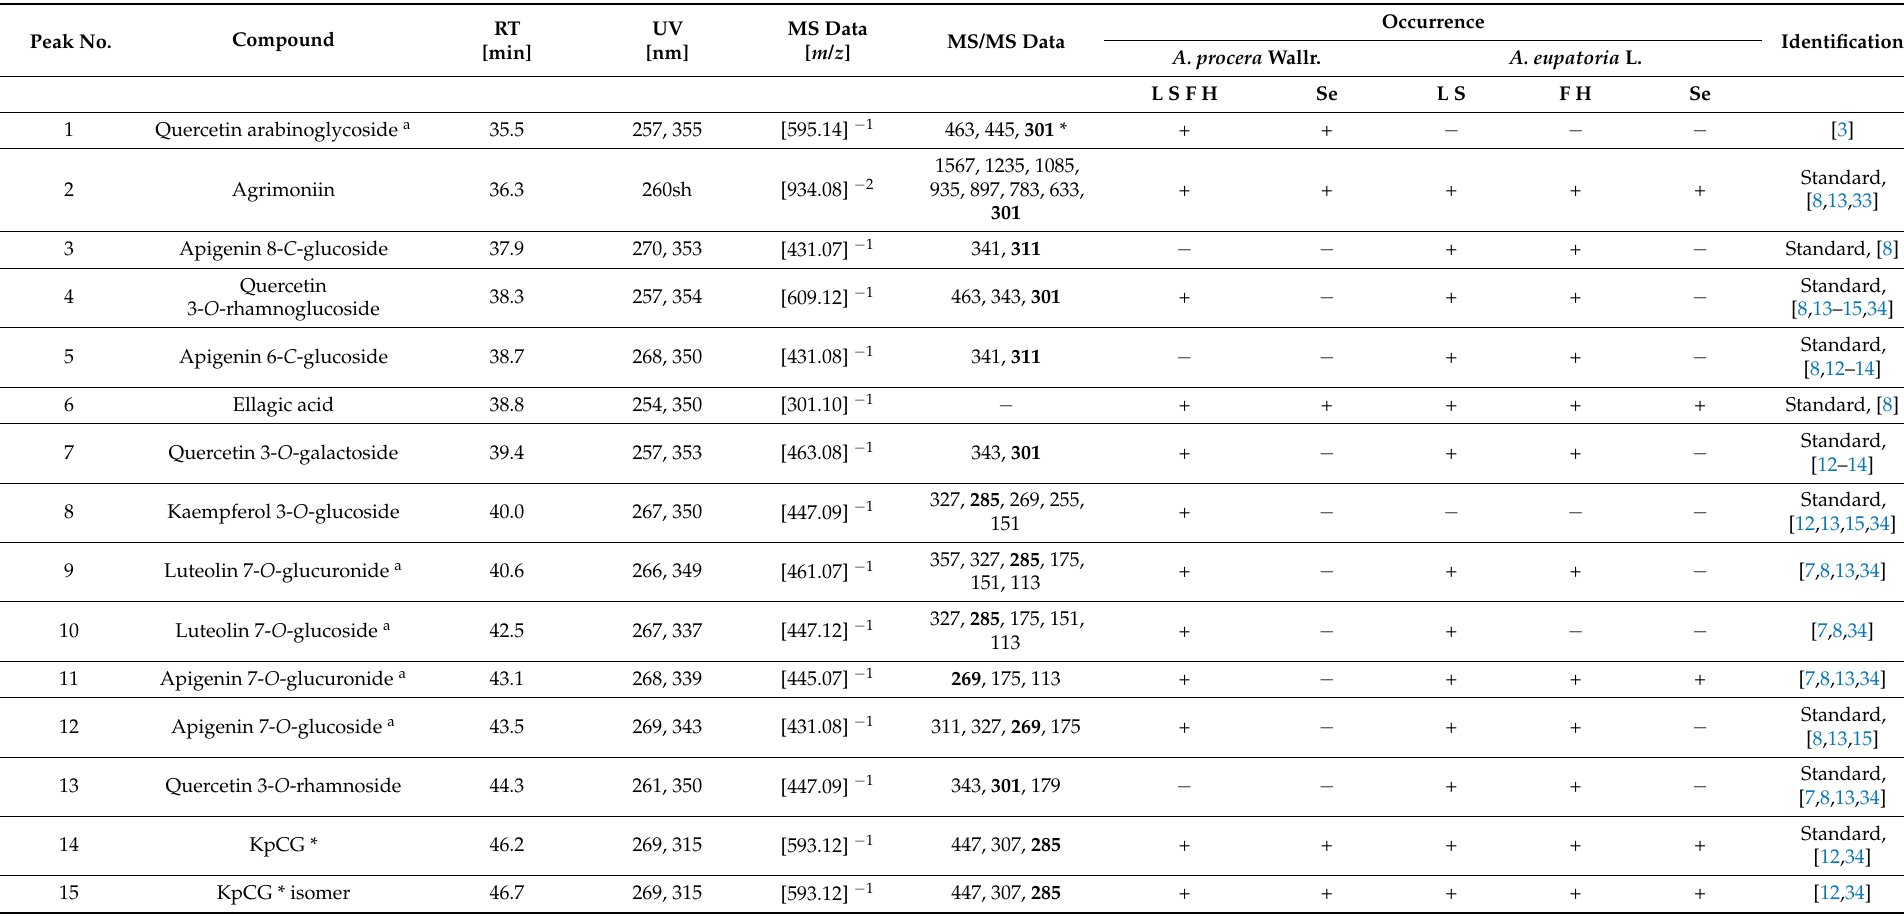
Table 1. LC-MS identification of agrimoniin and flavonoids in the leaves, stems, fruits, seeds, and hypanthia of A. procera and A. eupatoria . Peak No.